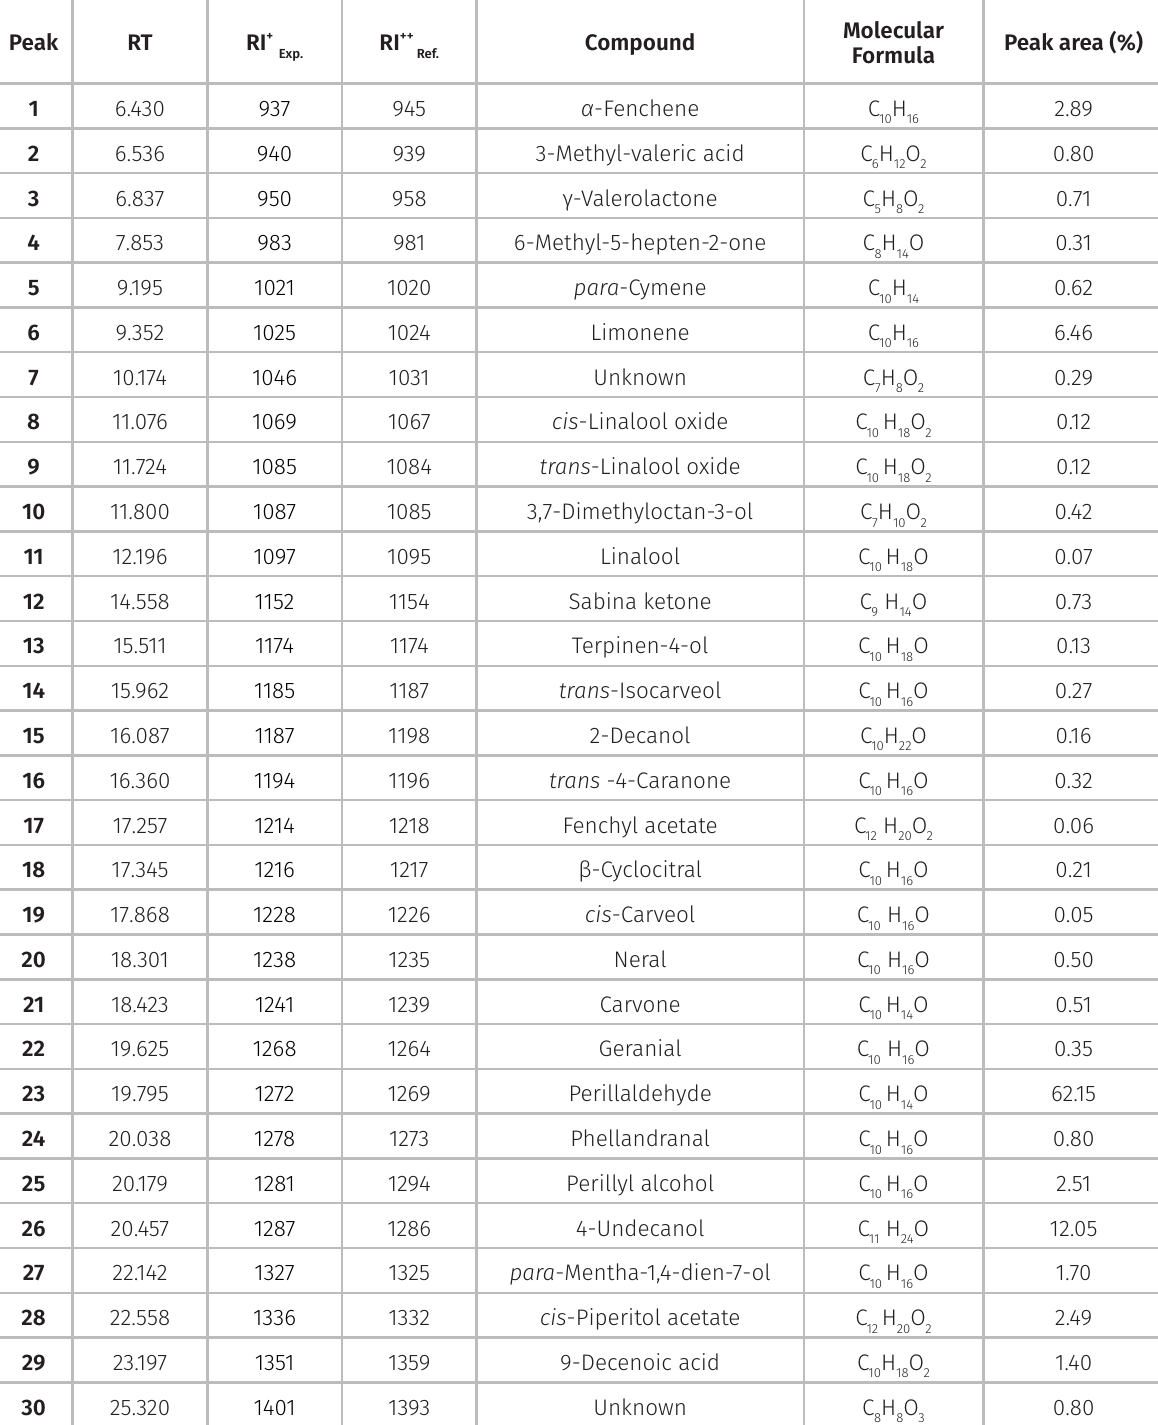
Table II. Chemical composition of the essential oil from the aerial parts of Pectis substriata , by GC/MS. Peak RT RI +